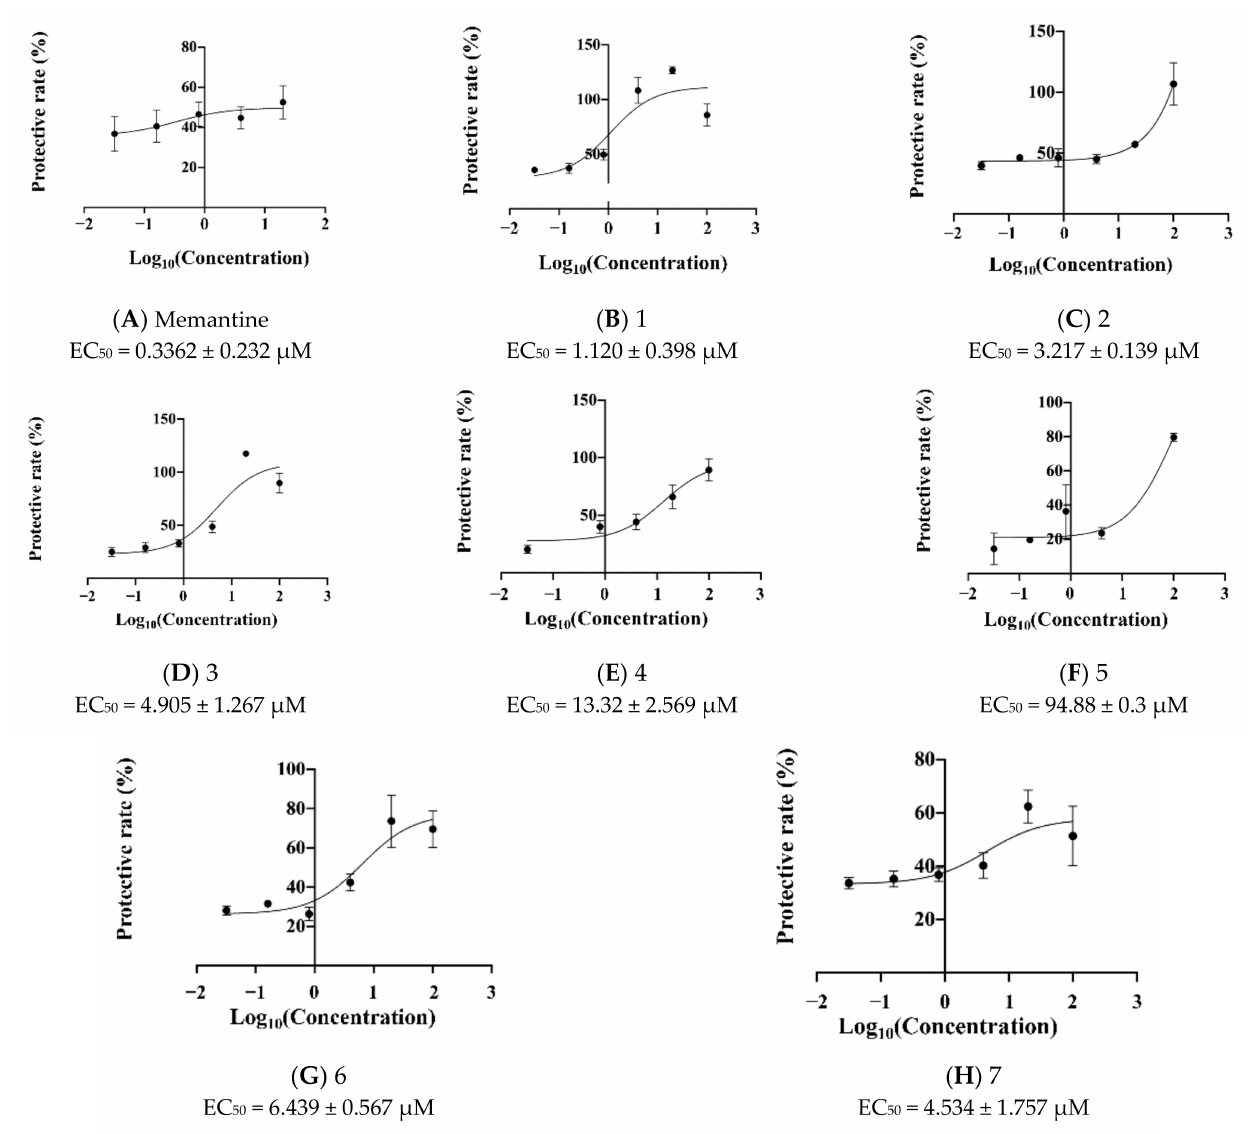
Figure 4. Value of EC 50 of novel structural derivatives of memantine against copper-induced toxicity. ( A – H ) Dose-dependent curve of memantine (as a positive reference drug) ( A ) and memantine derivatives, including 1 ( B ) modafinil-memantine, 2 ( C ) piracetam-memantine, 3 ( D ) picamilon- memantine, 4 ( E ) glycyl-glycine-memantine, 5 ( F ) glycyl-glycyl-glycine-memantine 6 ( G ) sarcosine- memantine, 7 ( H ) dimethylglycine-memantine. Data are expressed as mean ± SEM, n =